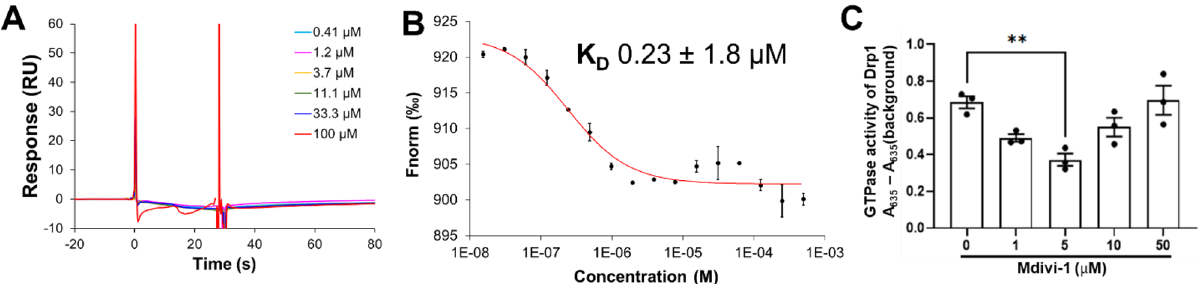
Figure 1. Binding affinity and Drp1 GTPase analyses of Mdivi-1. Representative ( A ) SPR and ( B ) MST results of Mdivi-1 (n = 2). ( C ) Mdivi-1 significantly inhibited Drp1 GTPase activity (n = 3). Data are expressed as mean ± SEM. ** p ≤ 0.01 by one-way ANOVA with Bonferroni post hoc